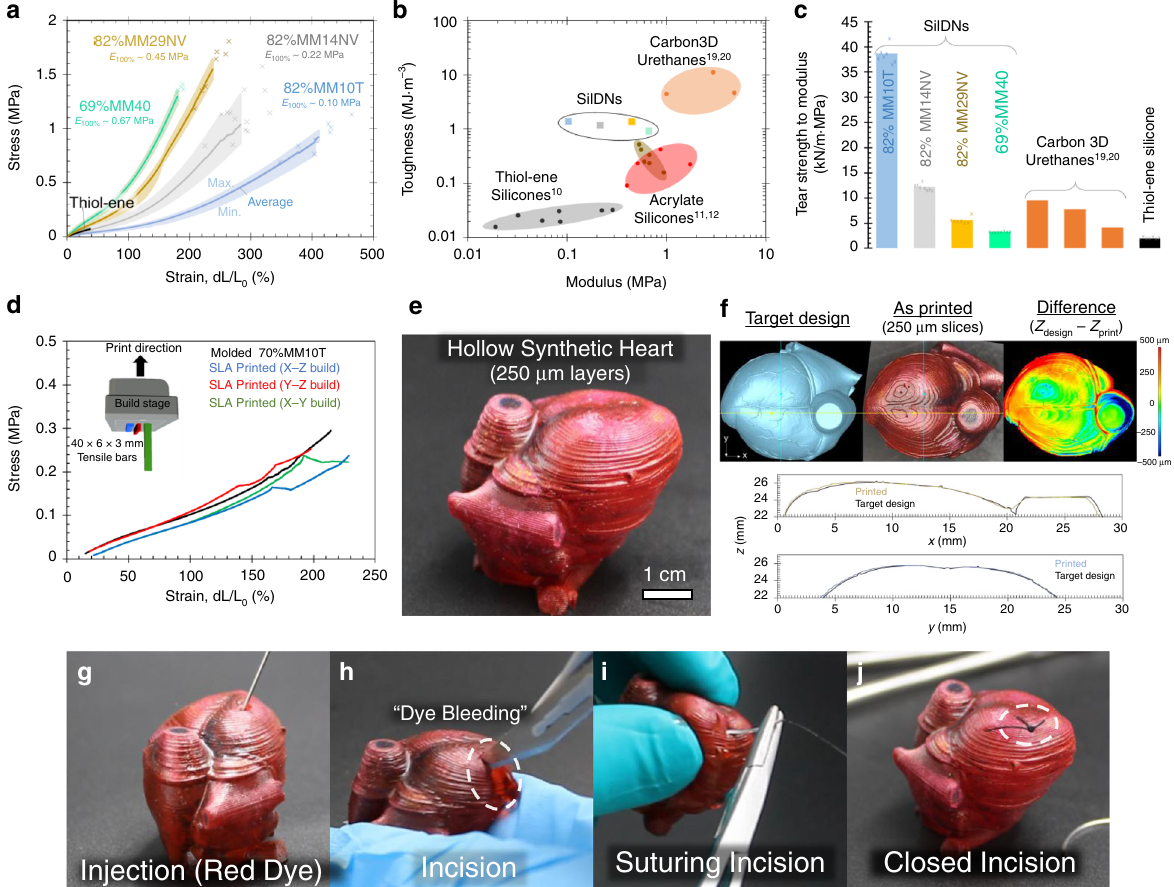
Fig. 2 Mechanical properties of SilDNs. a Combined tensile test data for the toughest printable material from each base condensation network (MM10T in light blue, MM14NV in gray, MM29NV in gold, and MM40 in green). Lines depict the average curve ( N > 7), shaded regions correspond to max and min stresses at each strain value, and “ x ” denotes actual failure points for each material. b Toughness vs. modulus for SLA-compatible silicones and commercial SLA polyurethanes ( N > 7). Material families are grouped by the shaded regions. c Normalized tear strength of double network silicones and commercial SLA polyurethanes with overlaid data points ( N = 7) for custom each material. d Average stress – strain curves for 70%MM10T as fabricated by different SLA print orientations ( X – Z build direction is the blue curve, Y – Z is red, X – Y is green) and molding (black curve) showing little anisotropy ( N > 3). e A 3D printed (64%MM10T) surgical simulator that replicates the organ morphology and elastic modulus of cardiac tissue. f Horizontal (yellow) and vertical (blue) topologies of the printed heart closely replicate that of the target design (black lines) as measured by laser confocal microscopy. g – j This hollow device enables simulation of numerous surgical skills. The high tear strength of the base material enables closing the incision with